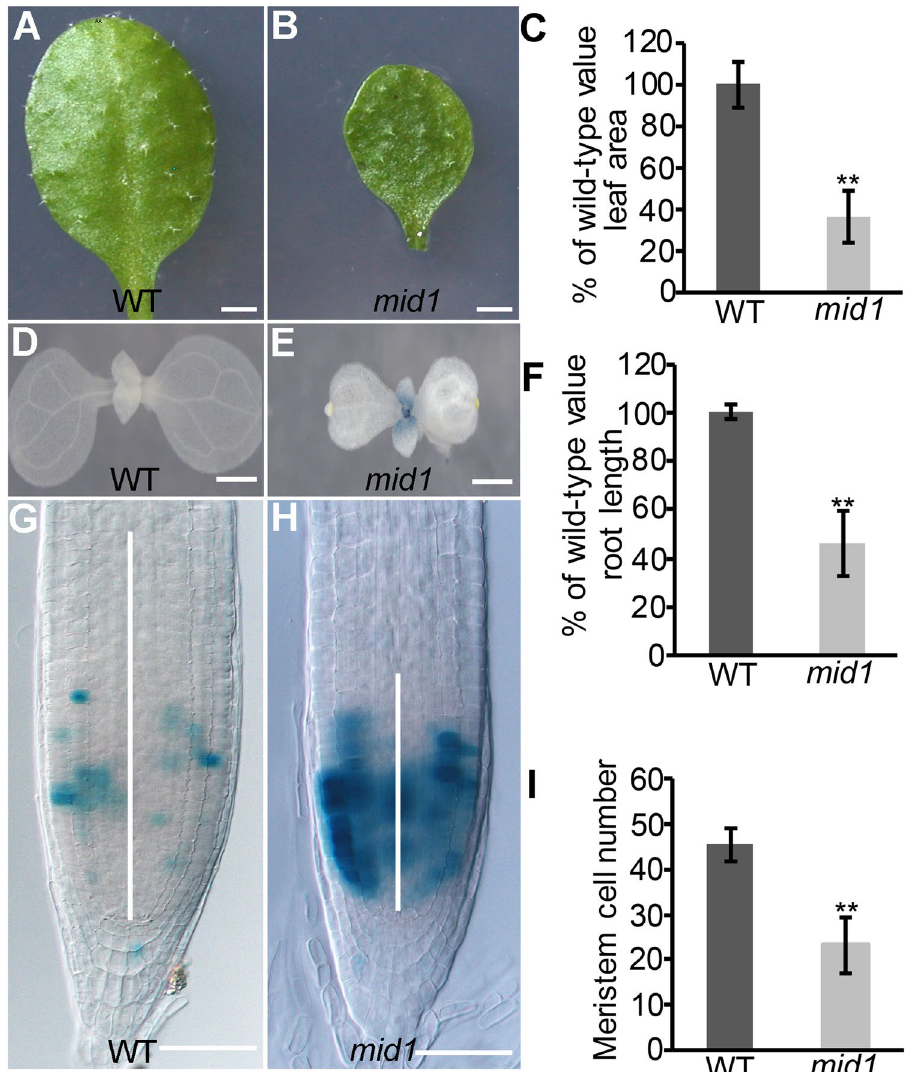
Figure 2. Cellular defects of mid1 . ( A ) Fifth leaf of 4-week-old wild-type plant. Bar = 0.3 cm. ( B ) Fifth leaf of 4-week-old mid1 plant. Bar = 0.3 cm. ( C ) Leaf area measurement of wild-type and mid1 . Data are the mean ± SE; n = 35. Student’s t tests were used to analyze differences between WT and mid1 . Double asterisks represent highly significant differences, ** P < 0.01. ( D ) Distribution of CYCB1;1-GUS in the 8-day-old wild- type true leaf. Bar = 1 mm. ( E ) Distribution of CYCB1;1-GUS in the 8-day-old mid1 true leaf. Bar = 1 mm. ( F ) Primary root length of 8-day-old wild-type and mid1 seedlings. Data are the mean ± SE, n = 40. Student’s t tests, ** P < 0.01. ( G , H ) Expression of CYCB1;1-GUS in the root meristem of 8-day-old wild-type and mid1 . The white lines indicate the meristem zone. Bars = 50 μ m. ( I ) Root meristem cells number of 8-day-old wild- type and mid1 seedlings. The root meristem cells are defined by the number of cortex cells in the cortical file extending from the QC to the transition zone. Data are the mean ± SE, n = 40. Student’s t tests, ** P <